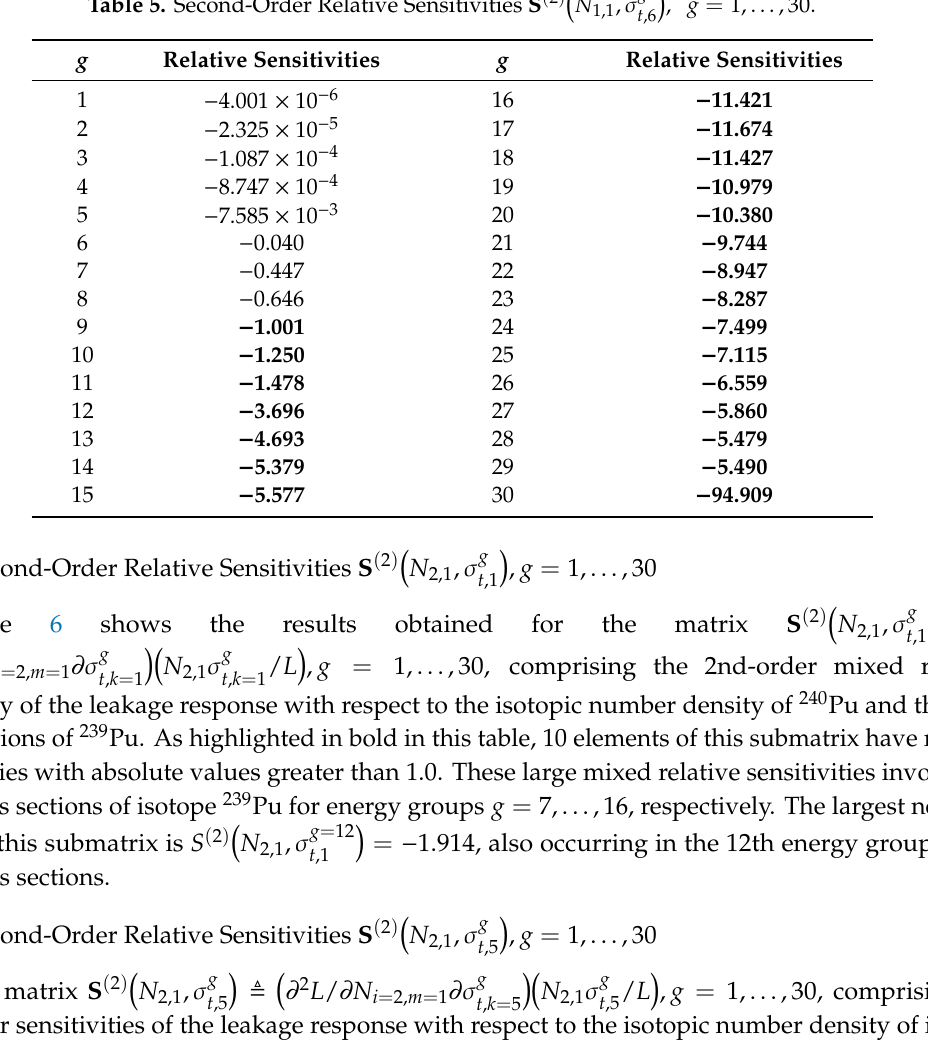
(cid:16) (cid:17) N 1,1 , σ g , g = 1, ... ,30. t ,6